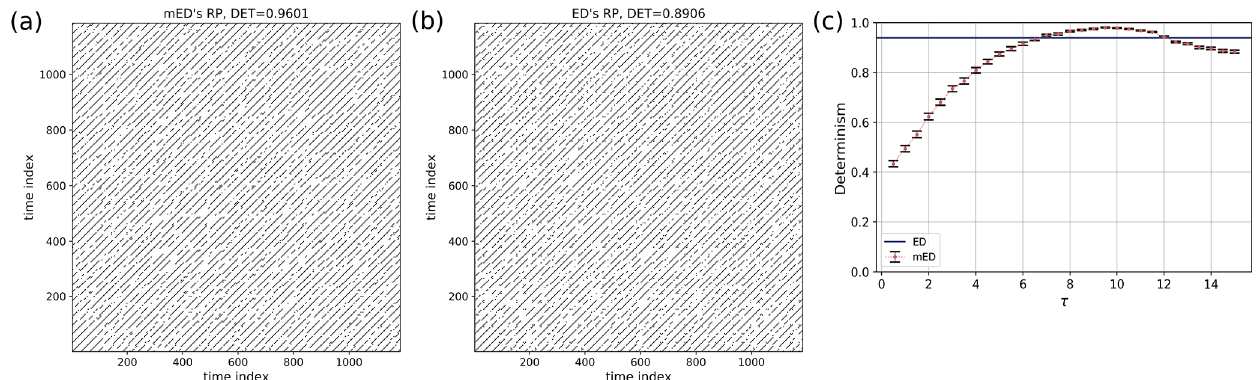
Figure 9. RP of a repeating Poisson process (Fig. 7b) using (a) mED and (b) ED; (c) comparison of DET for 300 realizations using ED (blue horizontal line) and using mED for varying τ in the range 0 to 15.